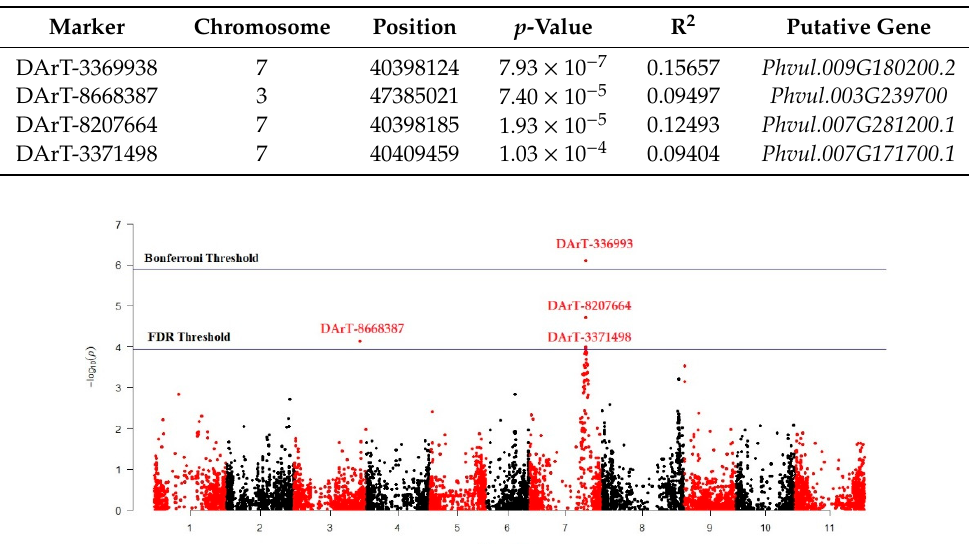
Table 4. Significant marker-trait associations identified for antioxidant activity in Turkish common bean germplasm.